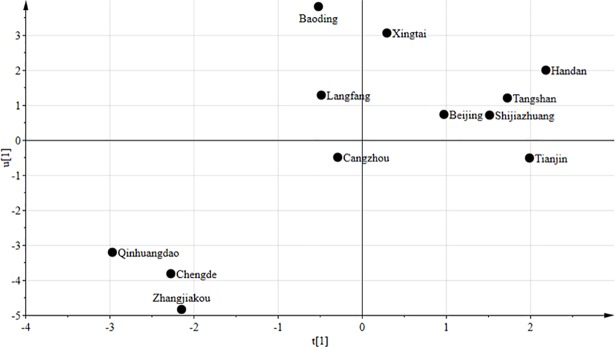
t1/u1 scatter plot.